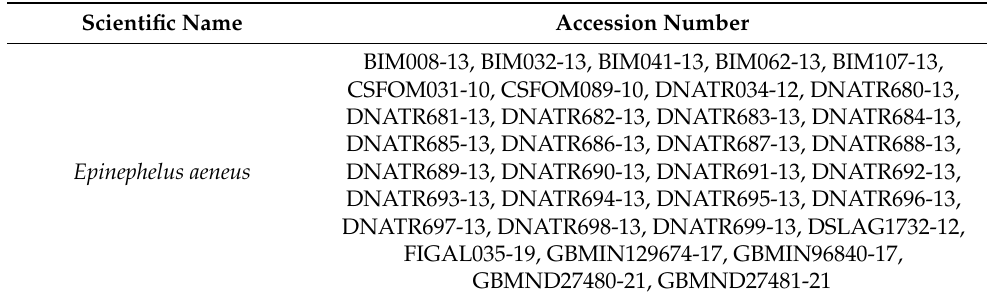
Table 2. List of the species analyzed from BOLD. Linkage between species, corresponding accession number and